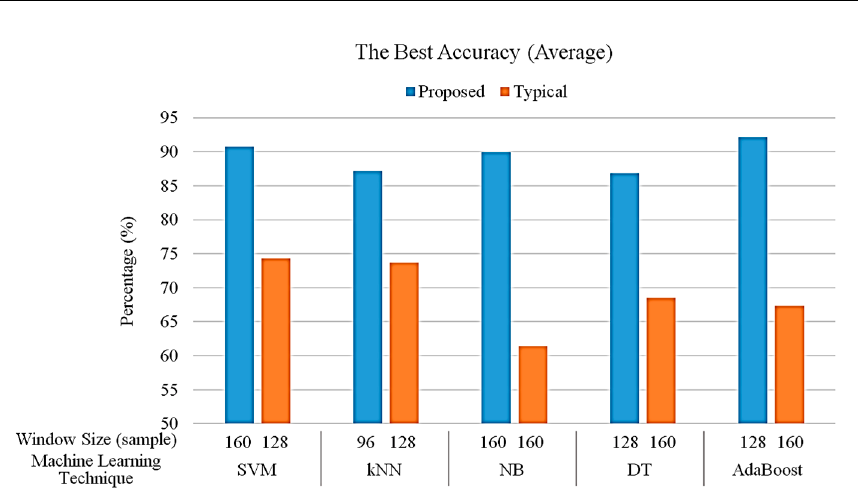
Figure 9. The best overall accuracy in each technique for proposed and typical machine-learning